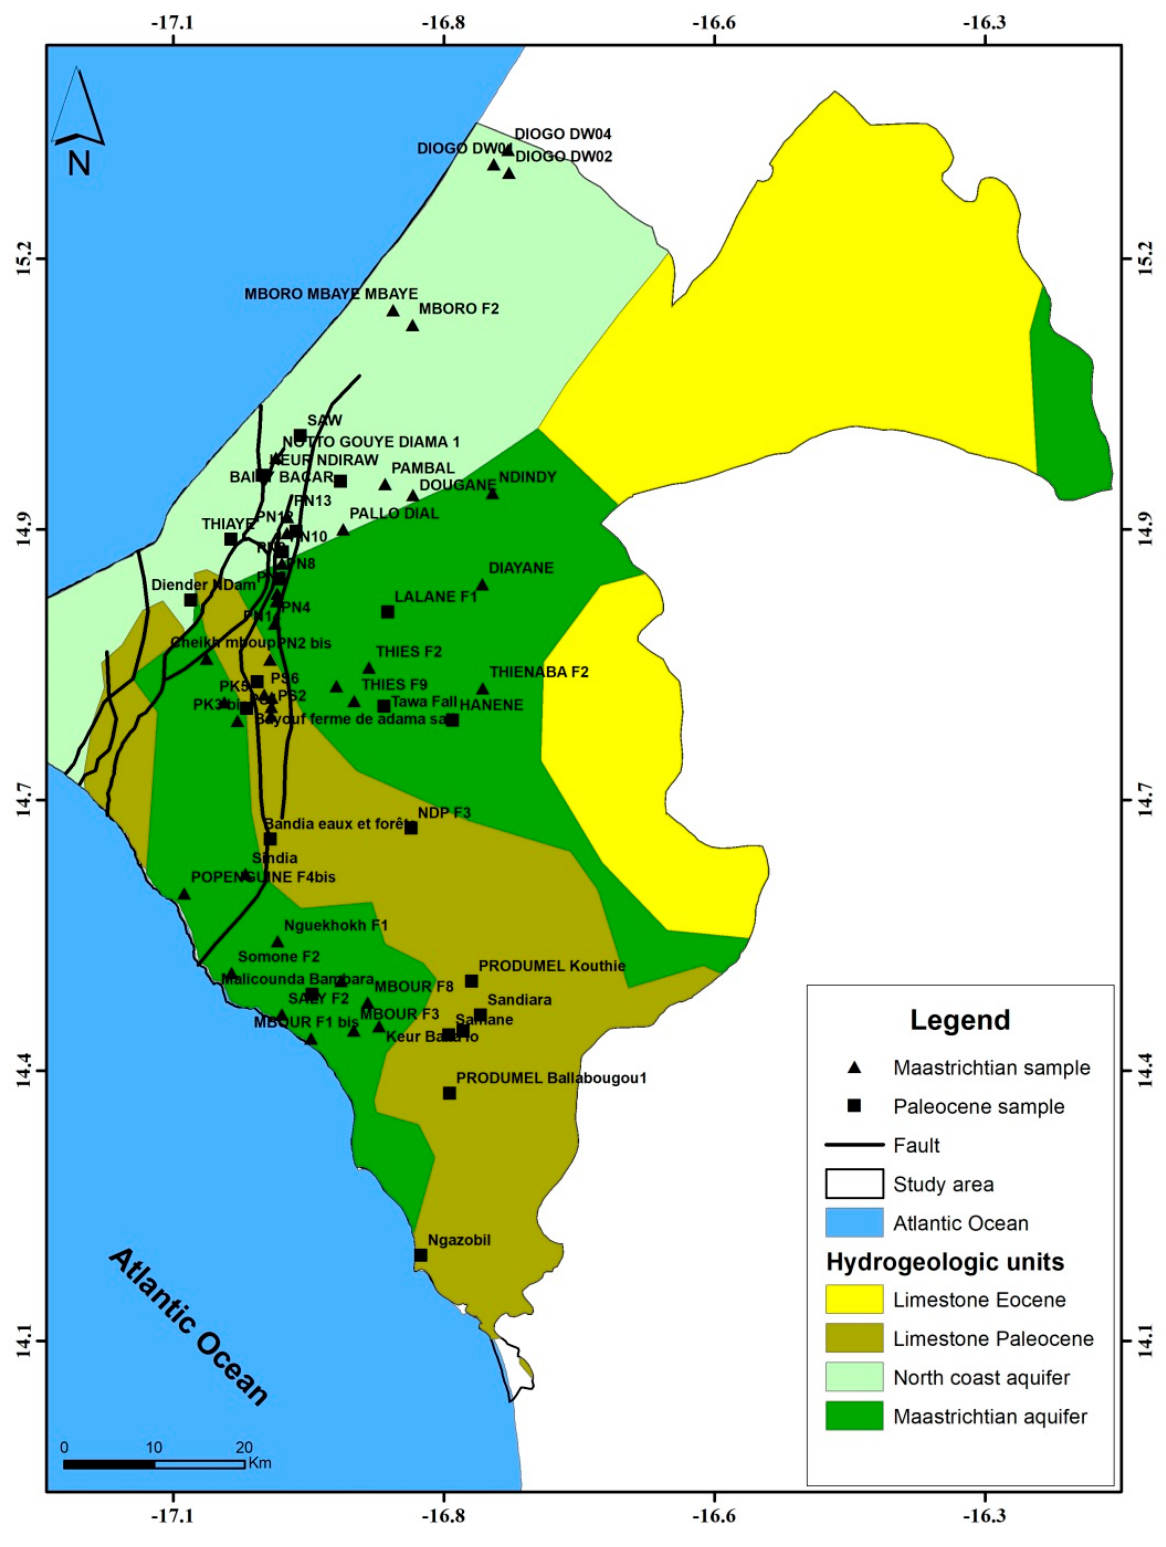
Figure 3. Location of the boreholes for groundwater sampling in the Thies region in 2019.